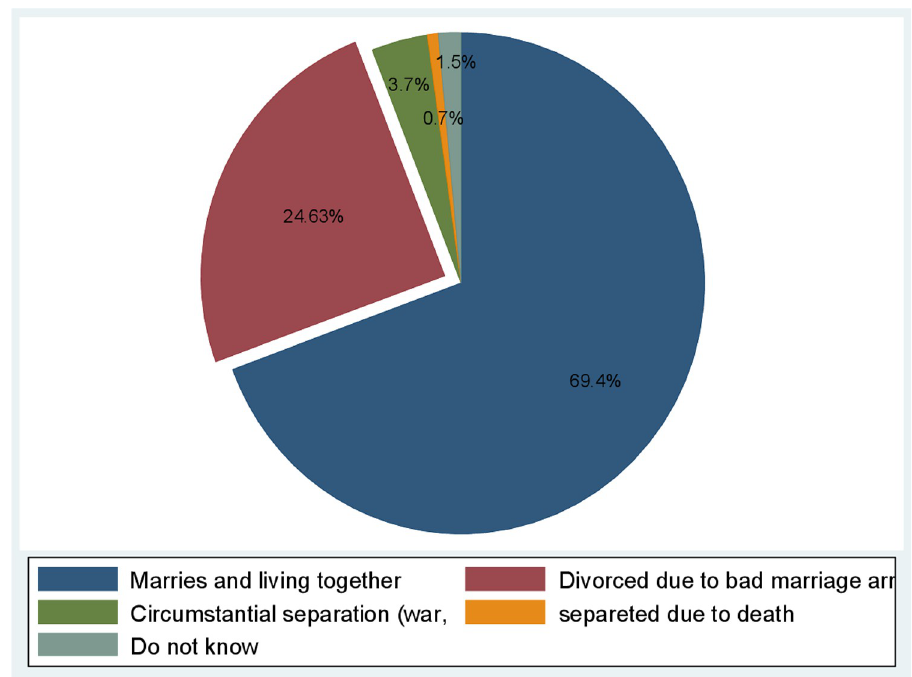
Fig 1. Prevalence of divorce among parents of street children Harar, eastern Ethiopia,